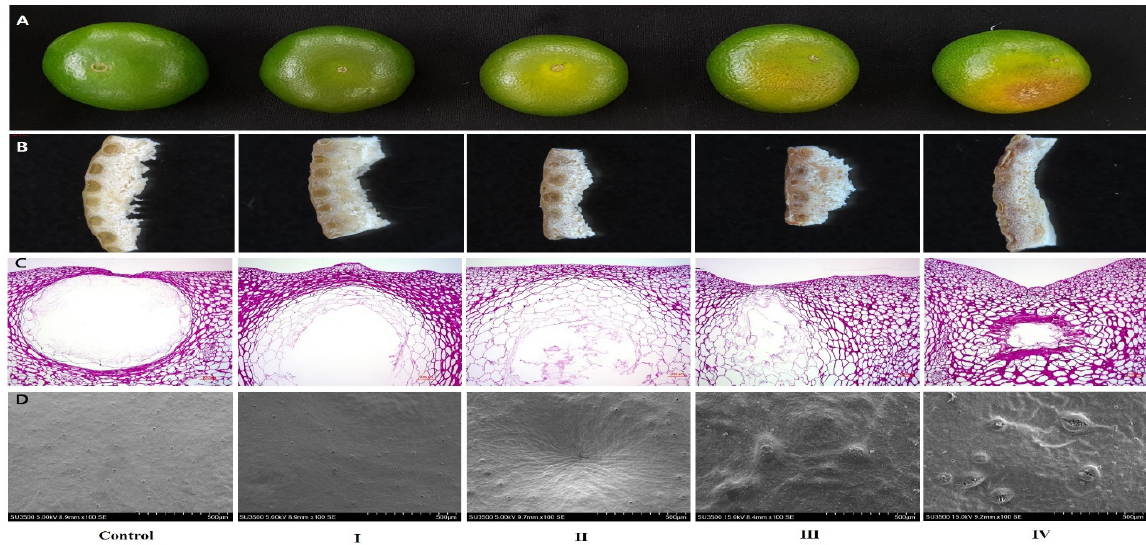
Figure 2. Anatomical and histological observations of unripe Satsuma mandarin fruits. ( A )